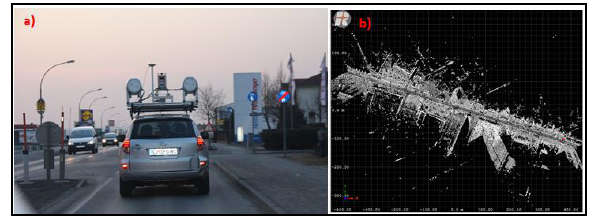
Figure 9: (a) Mobile mapping system (WideoCar) developed by Slovenian company DFG Consulting, (b) test point cloud for boresight alignment calibration (test site of Riegl company in Horn, Austria) (Kumar, 2013)